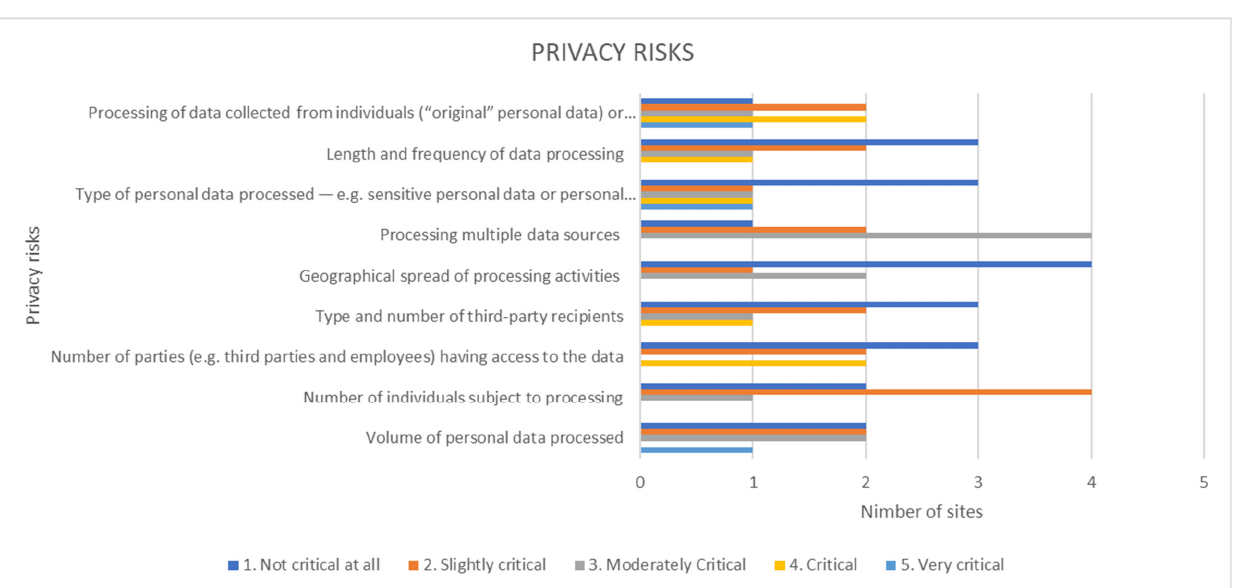
Figure 4. Data processing security-privacy risks.